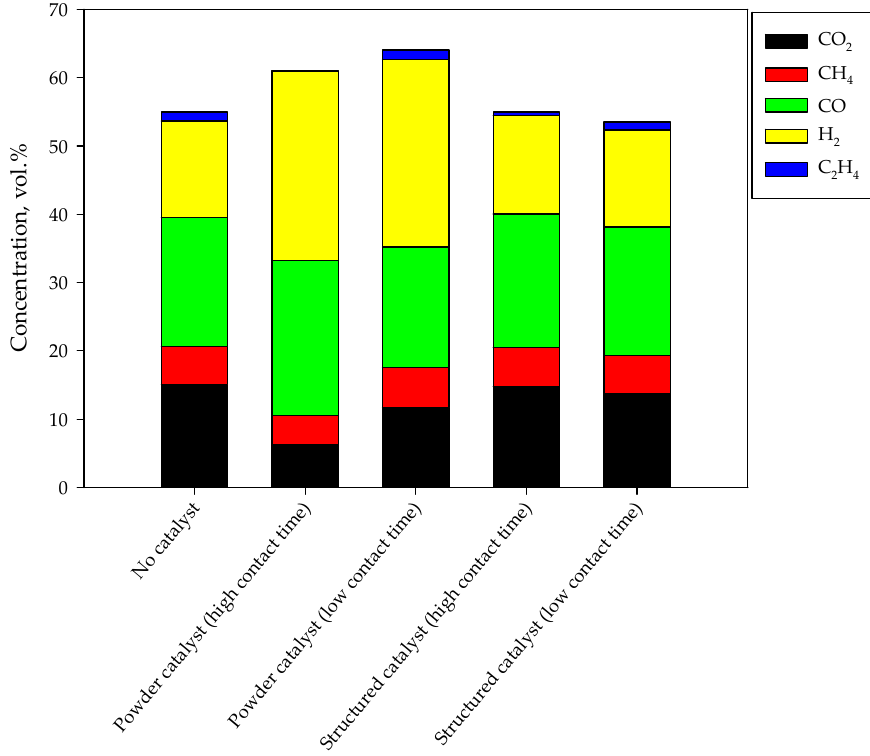
Figure 5. Gas composition during standard and enhanced gasification tests.